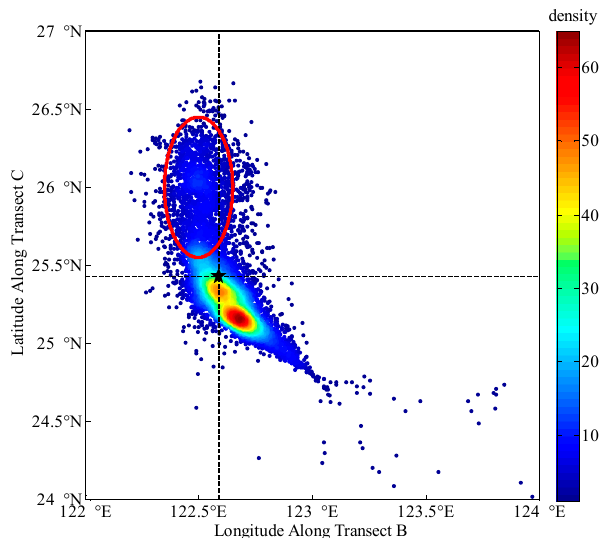
Figure 7. Scatter diagram of the longitudes of the intersections along Transect B versus latitudes of the intersections along Transect C for the long-term day-to-day detection of the Kuroshio axis from 1993 to 2016, Transects B and C are shown in Figure 3, the color codes represent the numbers of intersections, i.e., the data density. Black pentagram corresponds to the mean axis at (25.43°N, 122.59°E). Two black dashed lines are zonal and meridional extension lines. Latitudes along Transect C within the red ellipse represent the Kuroshio intrusion events.